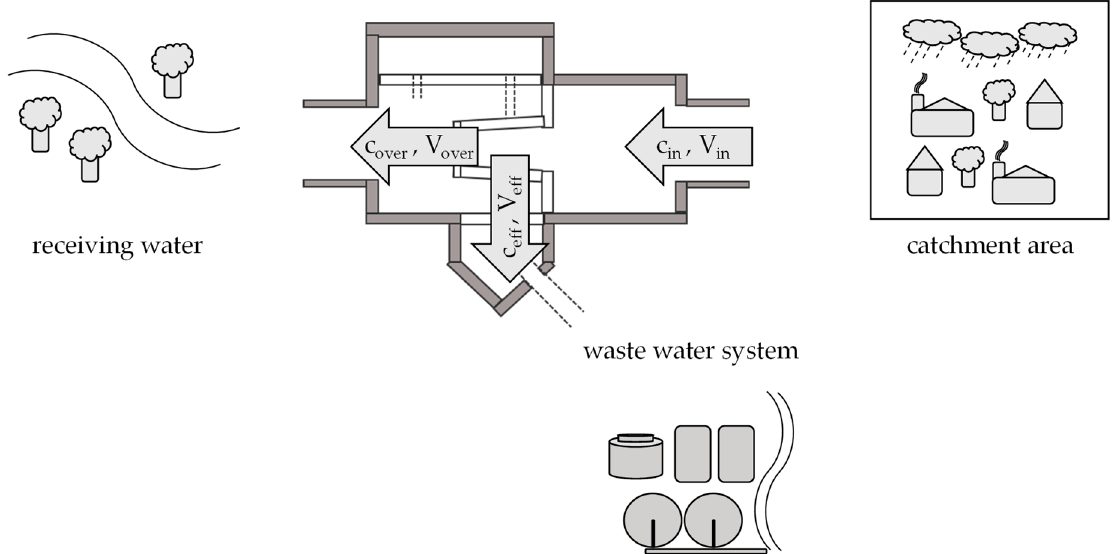
Figure 3. Schematic of the monitored stormwater treatment facility and it relevant flows (inflow, overflow and effluent). The flow to the receiving water consists of overflow and clearwater discharge.